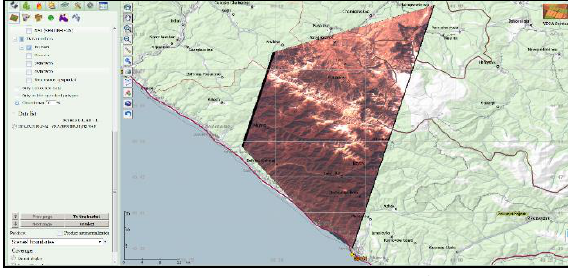
Figure 4. VEGA system user interface